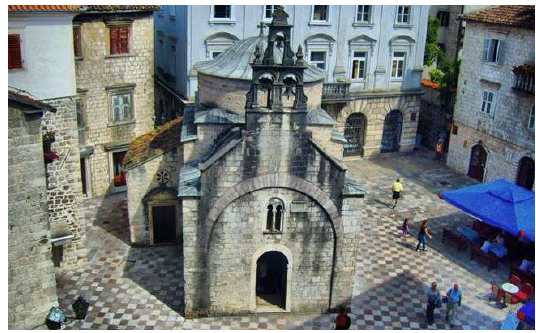
Figure 4. Church of St. Luke from the 12th century—cross-in-square plan.